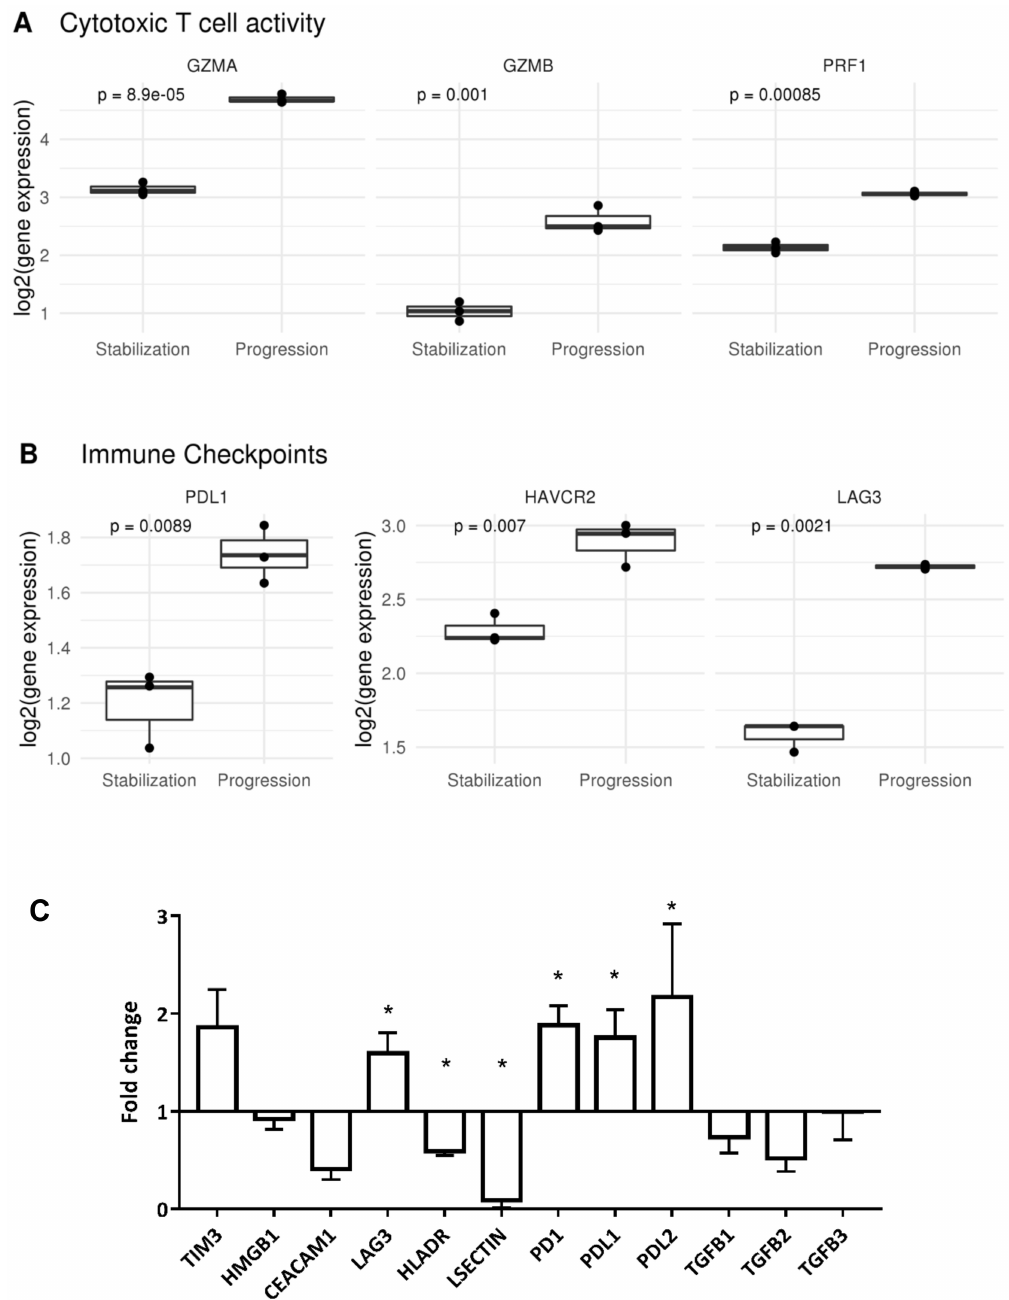
Figure 4. T lymphocytes activation / state phenotype was studied. ( A ) Granzimes and perforins showed an increased presence during progression stage, indicating a more activated T lymphocyte phenotype. ( B ) Exhaustion markers for T lymphocytes were also increased during progression. ( C ) Molecules associated to T cell exhaustion and immunosurveillance were analyzed by qPCR in both samples. Bars represent gene expression at the time of clinical progression. The result was normalized to the values of the sample corresponding to clinical stabilization (* p < 0.05). Fold change indicated how many times gene expression was higher / lower during progression compared to stabilization. During progression, exhaustion markers TIM3 (HAVCR2), LAG3, and PD1 were significantly